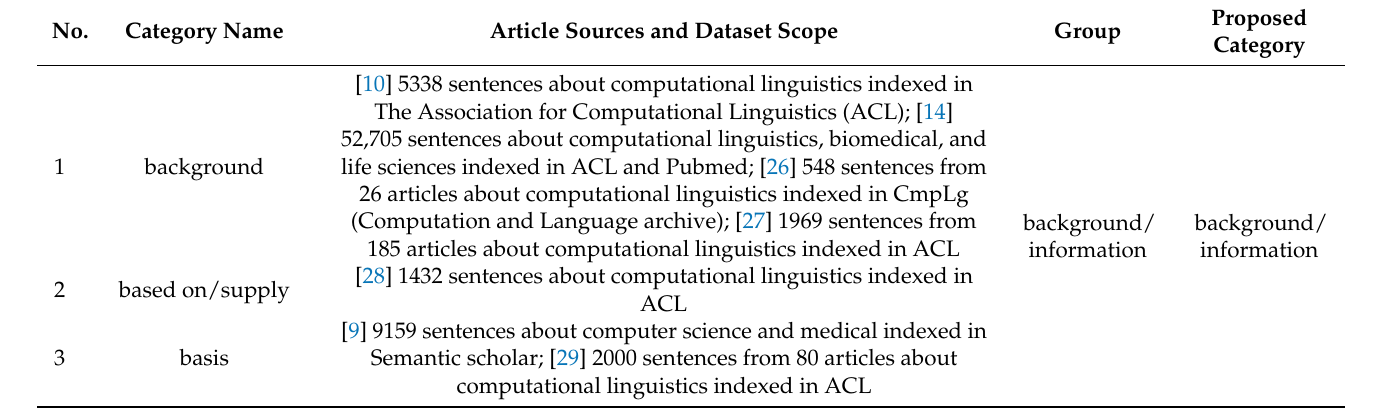
Table 2. Categories of citation functions in the literature and proposed